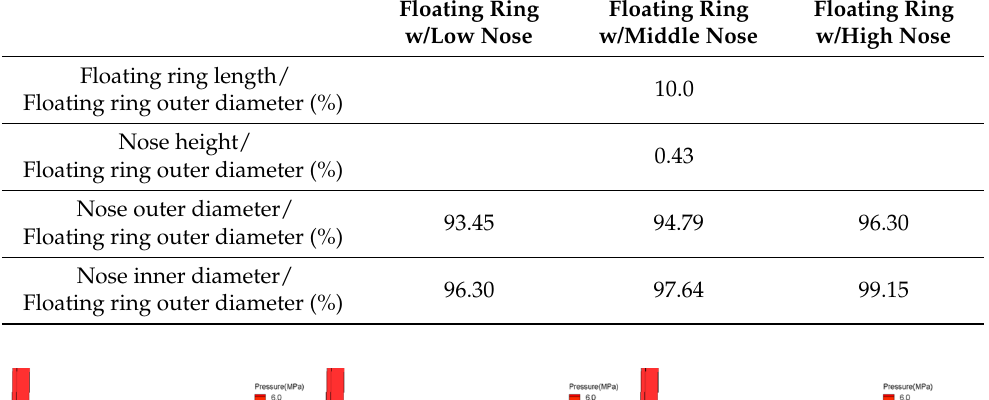
Table 1. Specifications of floating ring seal with 3 types of noses.